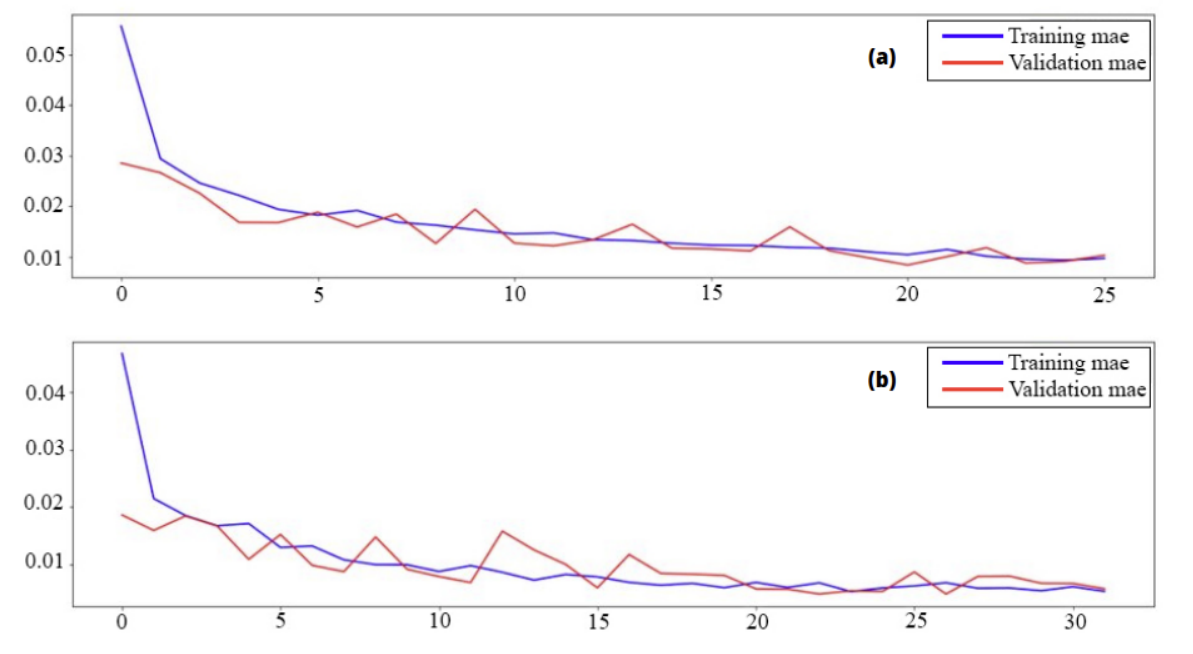
Figure 10. Mean Absolute Error curves using training and validation data consists in following the evolution of the training according to the number of epochs, ( a ) presents scenario 4 while ( b ) presents scenario